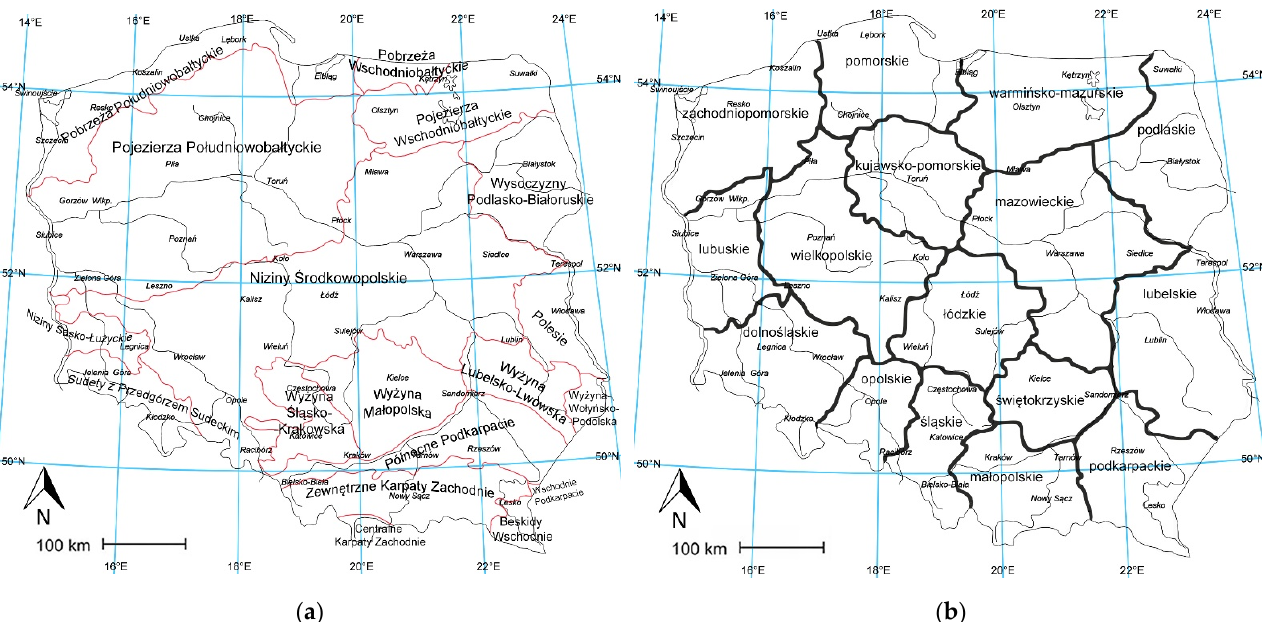
Figure 1. Distribution of weather stations in Poland: ( a ) geographical regions; ( b ) voivodeships. PL-EN: Beskidy Wschodnie-Eastern Beskids, Centralne Karpaty Zachodnie-Central Western Carpathians, Niziny Sasko- Ł u ż yckie-Lowlands Sasko- Ł u ż yckie, Niziny Ś rodkowopolskie-Central Polish Lowlands, Pobrze ż a Po ł udniowoba ł tyckie-South Baltic Coast, Pobrze ż a Wschodnioba ł tyckie-Eastern Baltic Coast, Podkarpacie Wschodnie-Eastern Subcarpathia, Pojezierza Po ł udniowoba ł tyckie-South Baltic Lakes, Pojezierza Wschodnioba ł tyckie-Eastern Baltic Lakes, Polesie–Polesie, Pó ł nocne Podkarpacie-Northern Subcarpathia, Sudety z Przedgórzem Sudeckim-Sudety Mountains with the Sudeten Foreland, Wysoczyzny Podlasko-Bia ł oruskie-Podlasie-Byelarus Uplands, Wy ż yna Lubelsko-Lwowska-Lublin-Lviv Upland, Wy ż yna Ma ł opolska-Ma ł opolska Upland, Wy ż yna Ś l ą sko-Krakowska-Silesia-Cracow Upland, Wy ż yna Wo ł y ń sko-Podolska-Volyn-Podolia Upland, Zewn ę trzne Karpaty Zachodnie-Outer West Carpathians.